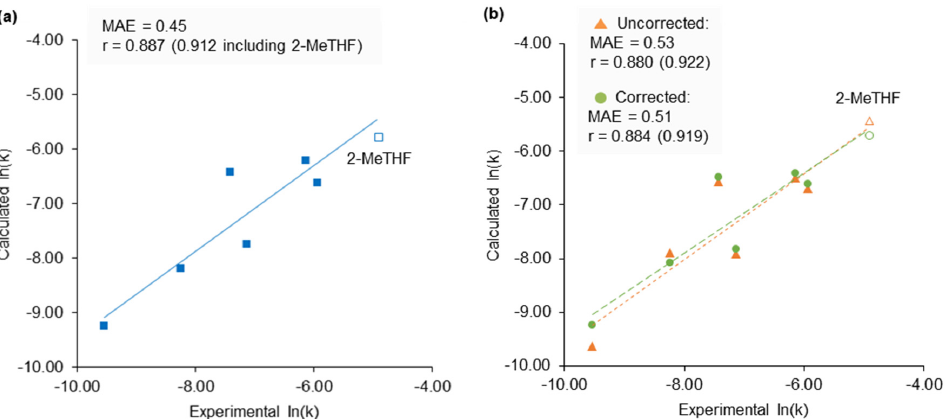
Figure 6. The predicted rate of a Michael addition using experimental and calculated KAT parameters. ( a ) Reaction rate constants calculated using experimental KAT parameters in Equation (4). The trendline is calculated without 2-MeTHF and extrapolated; ( b ) Calculated KAT parameters used to solve Equation (4) for the prediction of ln(k) and compared to experimental data. Trendlines are calculated without 2-MeTHF and extrapolated.